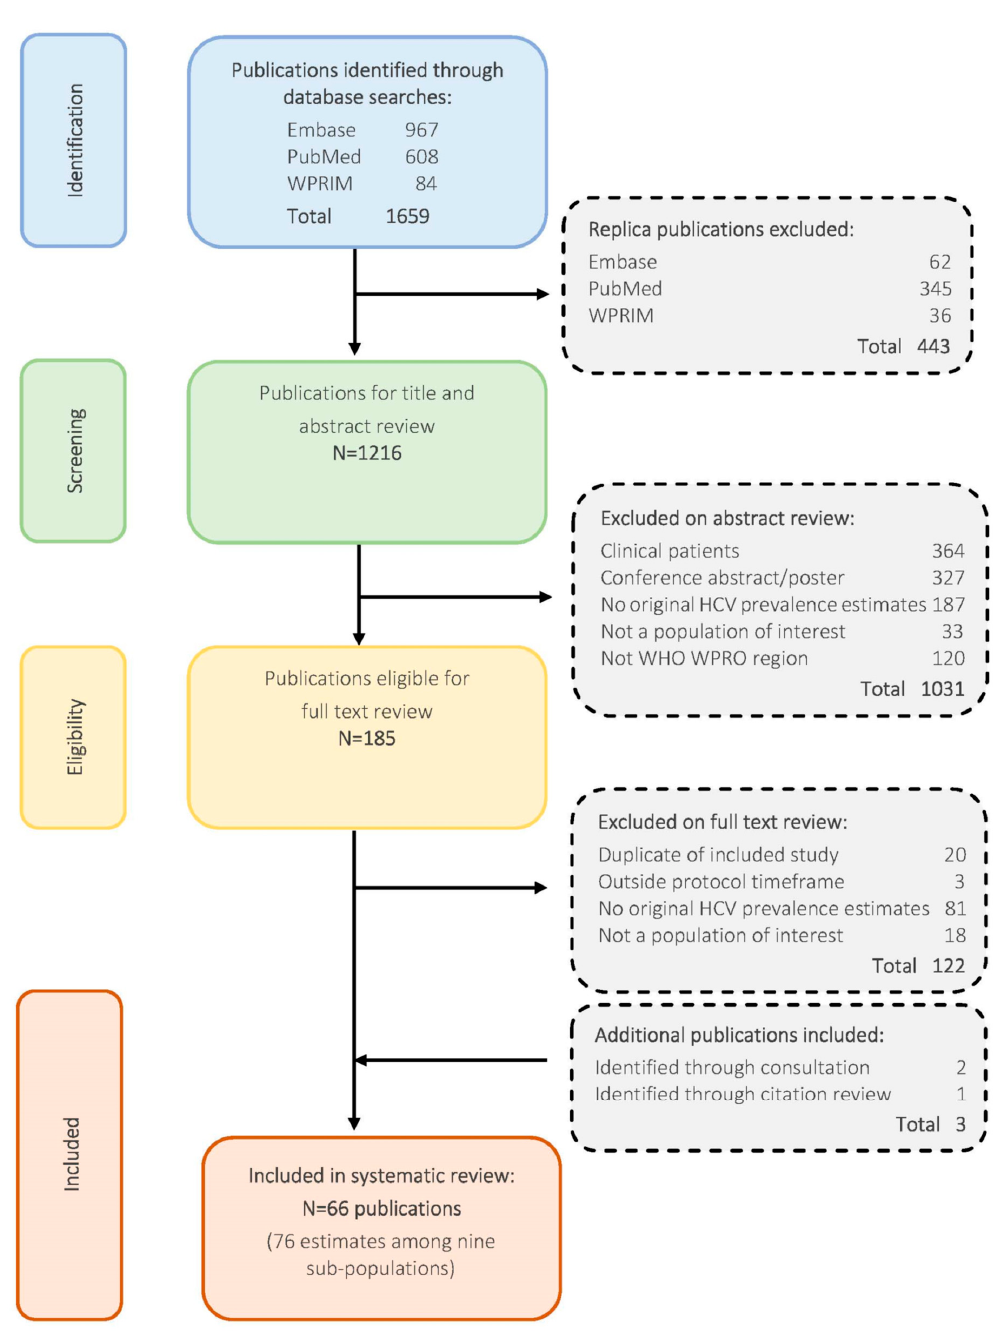
Figure 1. Flow chart of publication identification and selection process.